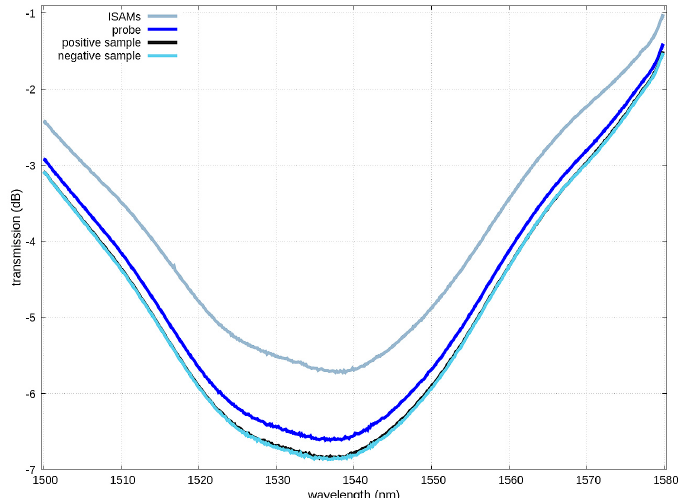
Figure 2. Transmission spectra after different steps of the assay. Adding the probe to the ISAM-coated fiber caused a large increase in attenuation. The attenuation was further increased after exposing the sensor to the positive control. However, further exposure of the fiber to the negative control did not result in any further change in attenuation, as was expected. As a result, the negative control spectrum overlaps and is indistinguishable from that of the positive control.